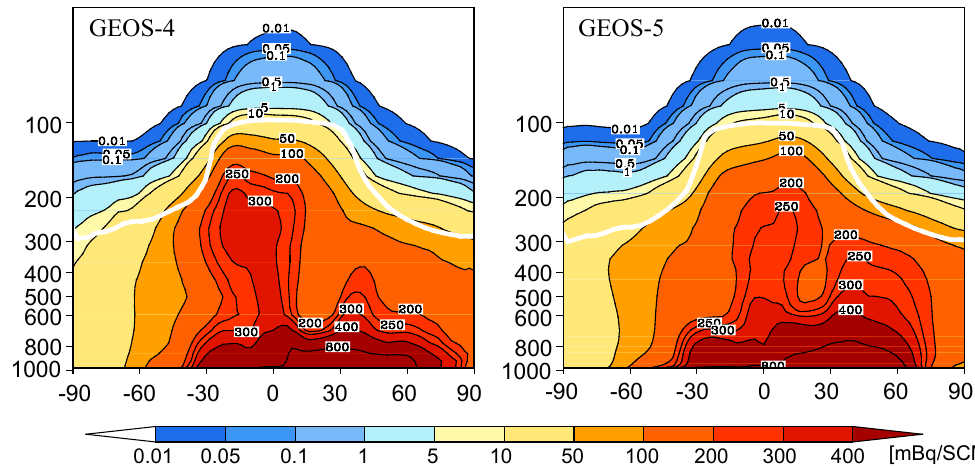
Fig. 5. Annual, zonal mean 222 Rn [mBq/SCM] from a GEOS-Chem simulation driven by GEOS-4 and GEOS-5 meteorological data for 2006. White line indicates the World Meteorological Organization (WMO) thermal tropopause.